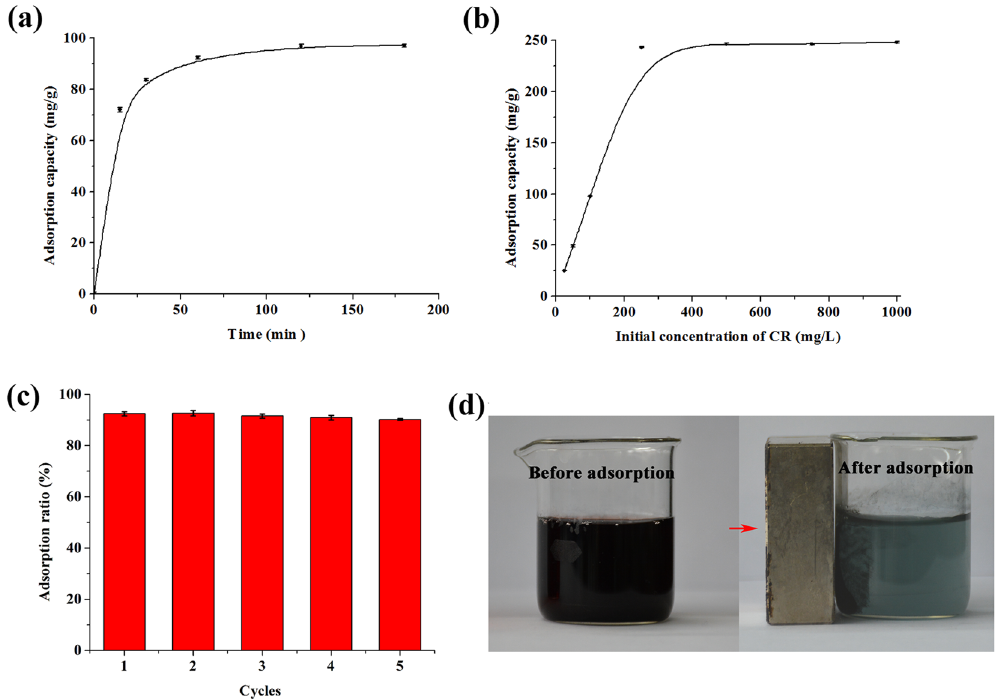
Figure 9. ( a ) Effect of contact time on adsorption of GS/PANI/Fe 3 O 4 -4 to CR, ( b ) Effect of initial concentration of CR on the adsorption of GS/PANI/Fe 3 O 4 -4 to CR, ( c ) Adsorption ratio for 100 mg/L CR as a function of adsorption-desorption cycle, and ( d ) Digital photographs of the mixed solution composed of 50 mg/L of BG and CR before and after adsorption using GS/PANI/Fe 3 O 4